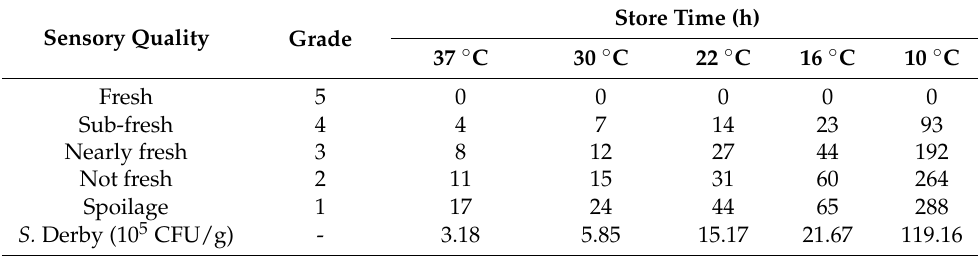
Table 4. Sensory changes in simulated contaminated pork at different temperatures and prediction of shelf life based on S. Derby